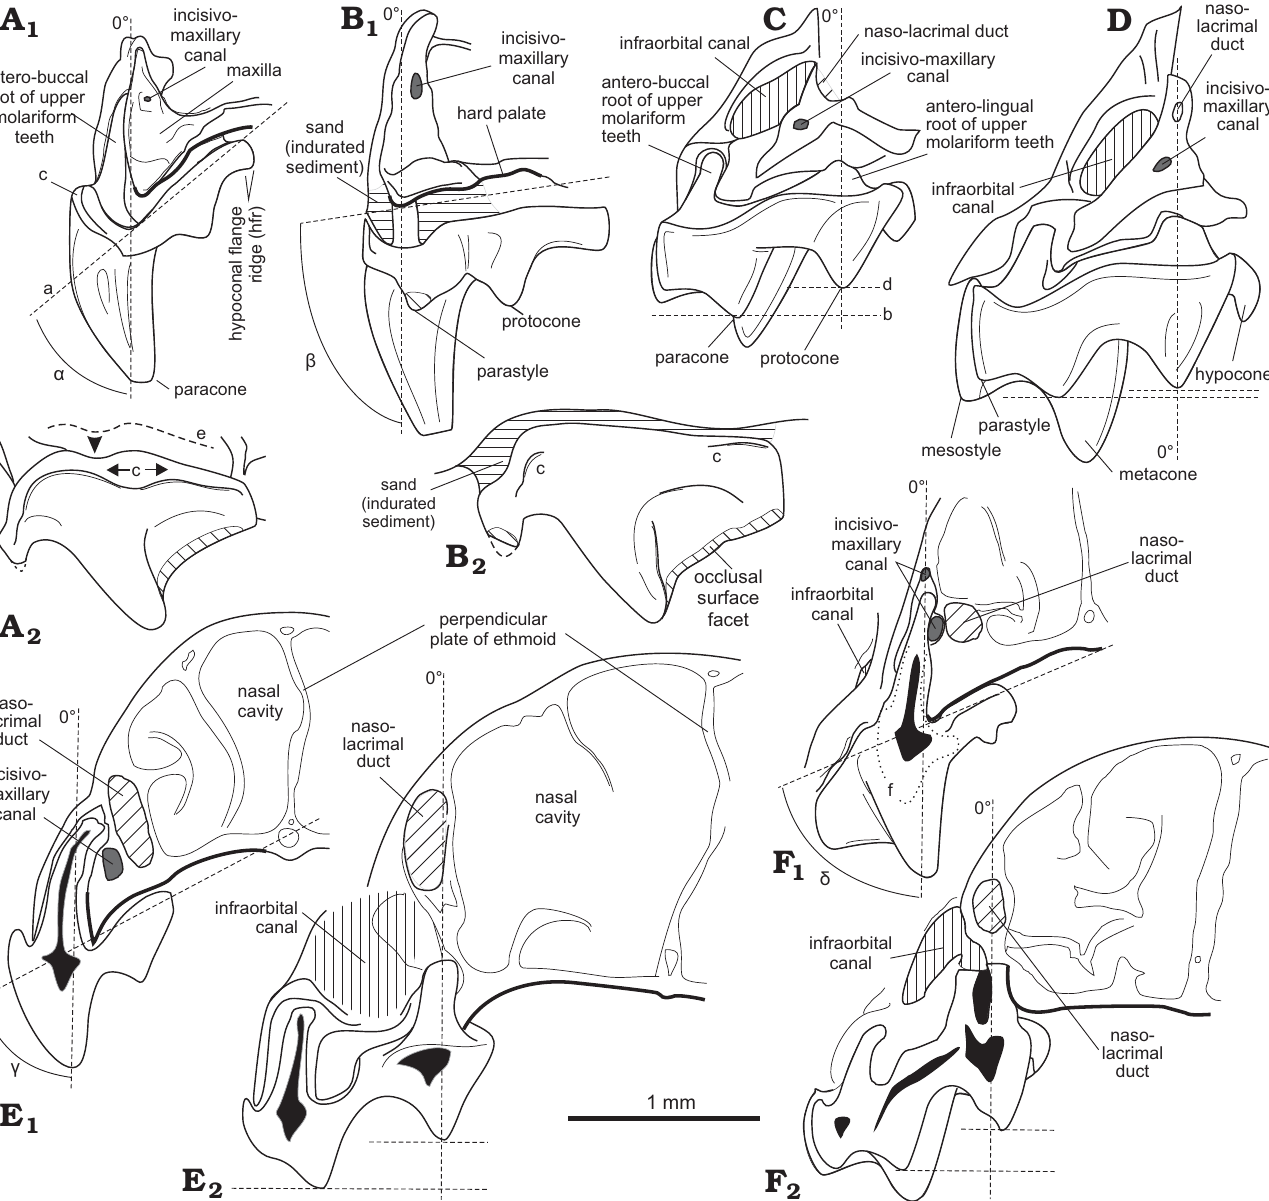
4. Specific features of crocidosoricine shrews Shargainosorex angustirostris gen. et sp. nov. from middle Miocene Sharga 2 locality, Mongolia (A,